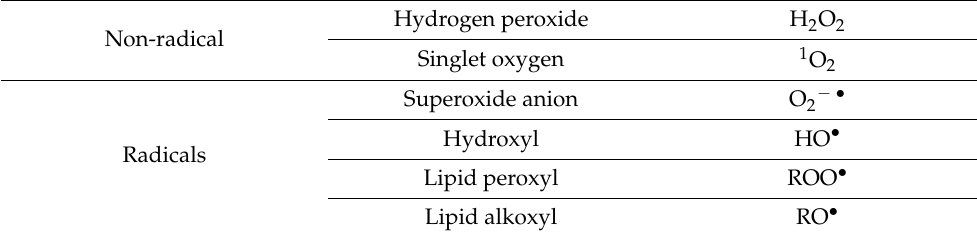
Table 3. Main reactive oxygen species (ROS)